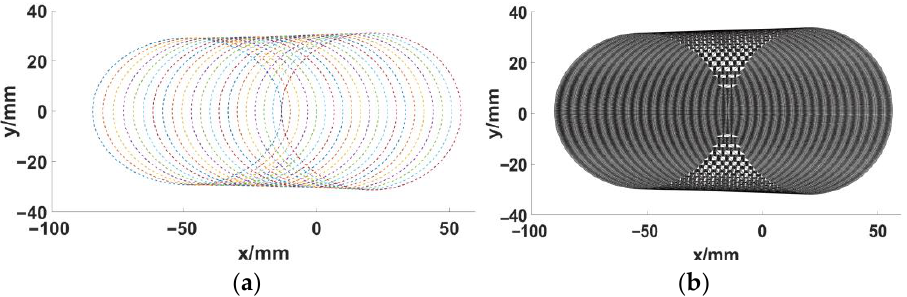
Figure 2. ( a ) Scan path of the THz rotation mirror imaging system and ( b ) triangulation of the scan points.